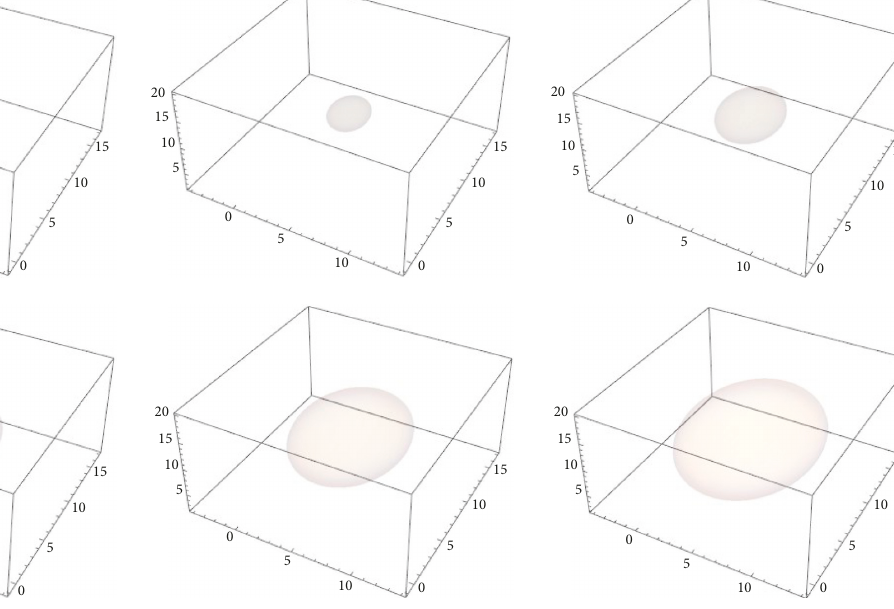
Figure 5: ( A + B ) , 0 − cut ∼ 1/2 − cut.